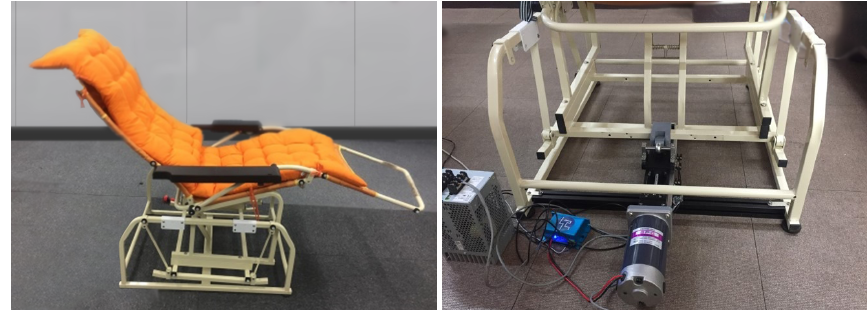
Figure 1. Designed recliner chair.